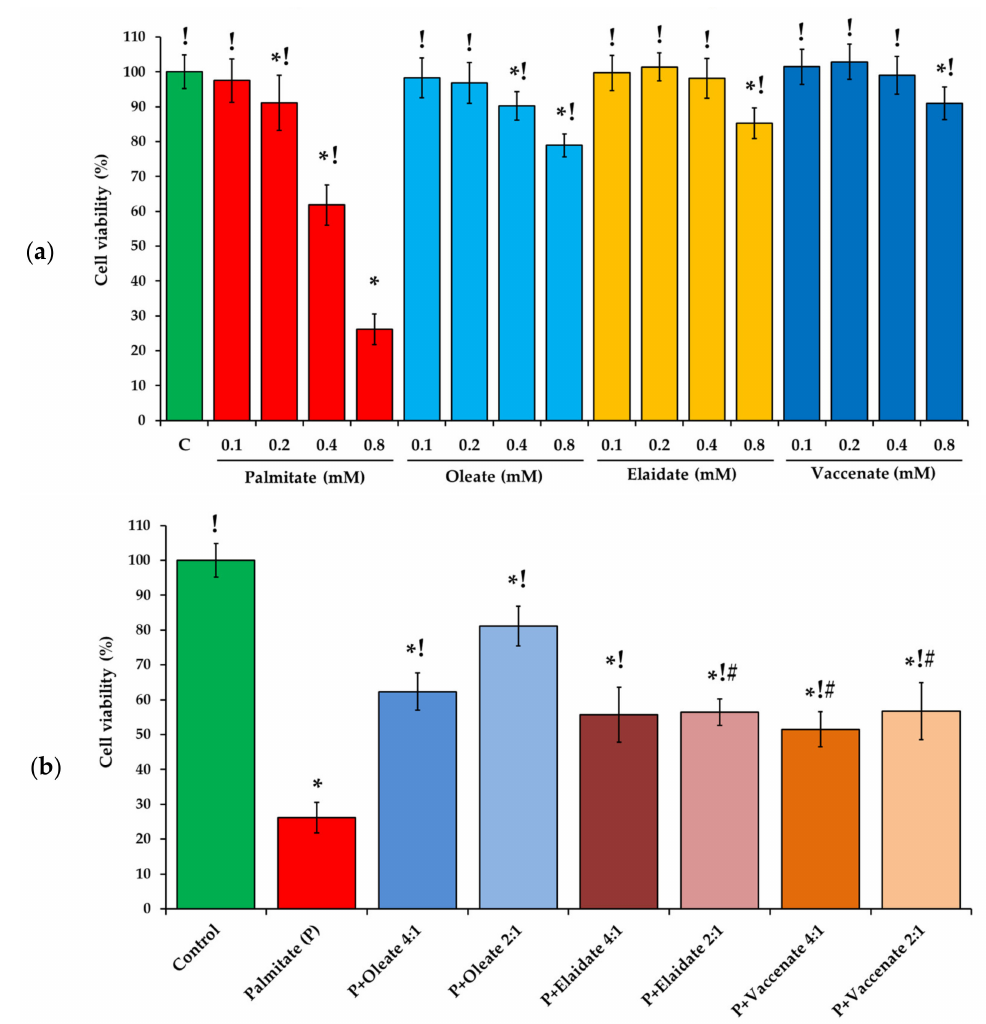
Figure 1. Viability of cell treated with fatty acids at various concentrations. Cells were treated with ( a ) BSA-conjugated palmitate, oleate, elaidate or vaccenate (100–800 µ M) or with ( b ) palmitate (800 µ M) and oleate, elaidate or vaccenate at a 4:1 or 2:1 molar ratio (200 or 400 µ M) at 70–80% confluence for 24 h. Cell viability was assessed by the Colorimetric (MTT) Kit for Cell Survival and Proliferation (Millipore) and expressed as the percentage of the control. Data are shown as mean values ± S.D.; n = 18; statistically significant differences: * p < 0.05 vs. BSA treated control; ! p < 0.05 vs. 800 µ M palmitate treated samples; # p < 0.05 vs. palmitate and oleate treated cells in case of combinational treatments at the corresponding